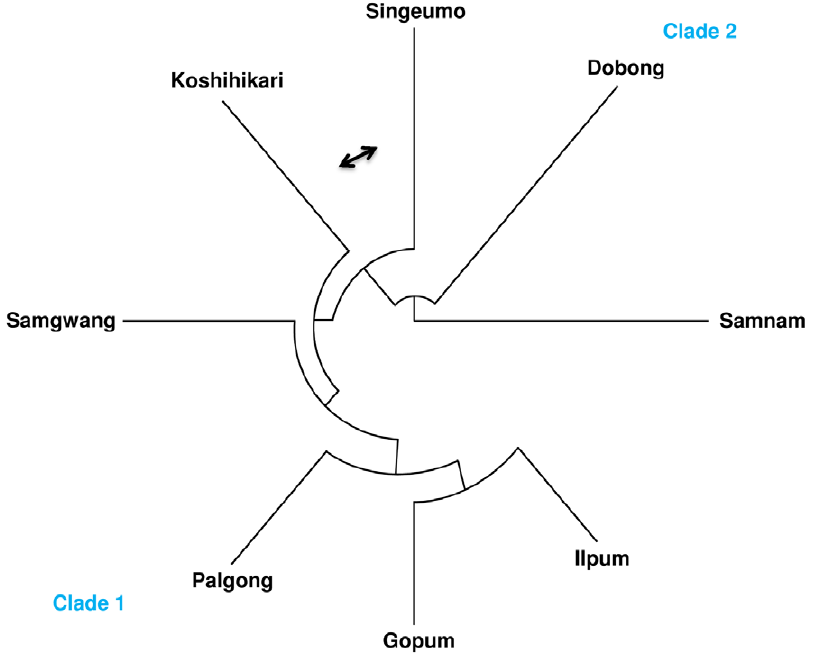
Figure 3. UPGMA tree based on 35 SNPs and insertion-deletions from five genes in eight japonica varieties. The 35 SNPs and insertion- deletions are as follows: S2, S3, S4, S5, S6, S7, S8, S9, S11, S12, S13, S14, S16, S18, S19, S20, S21, S22, S24, S30, S31, S32, S33, S34, S35, S37, S38, S39, S40, S41, S44, S48, S55, S58, S60 (See Table S4). doi:10.1371/journal.pone.0018385.g003 PLoS ONE |